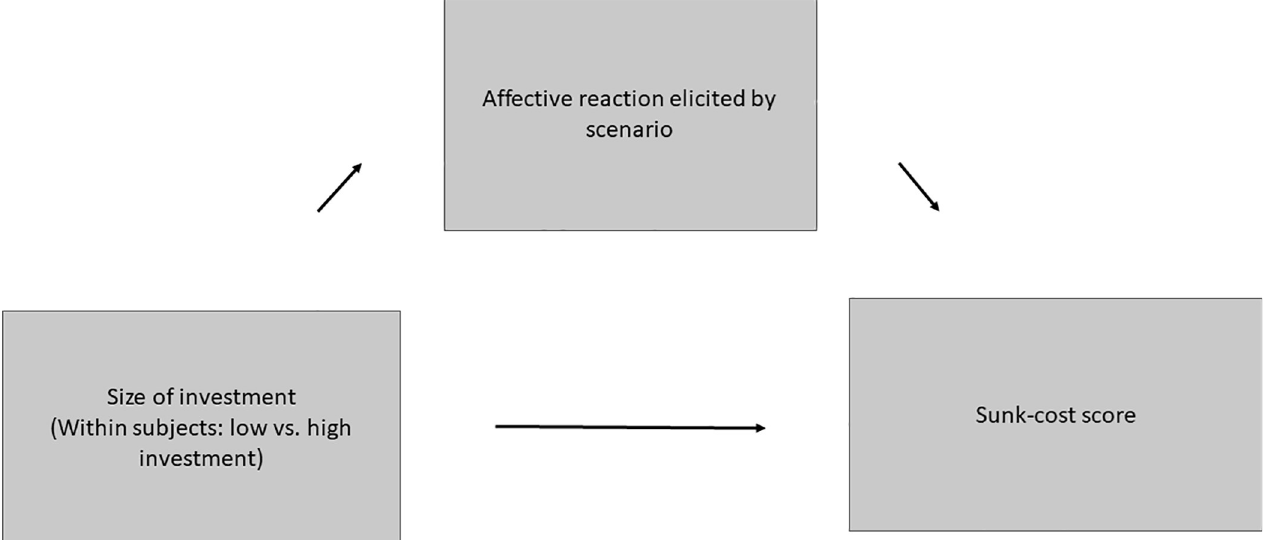
Fig 4. Within-participant mediation model; effect of condition (low vs. high investment) on sunk-cost scores through affective reaction in the high-load condition.